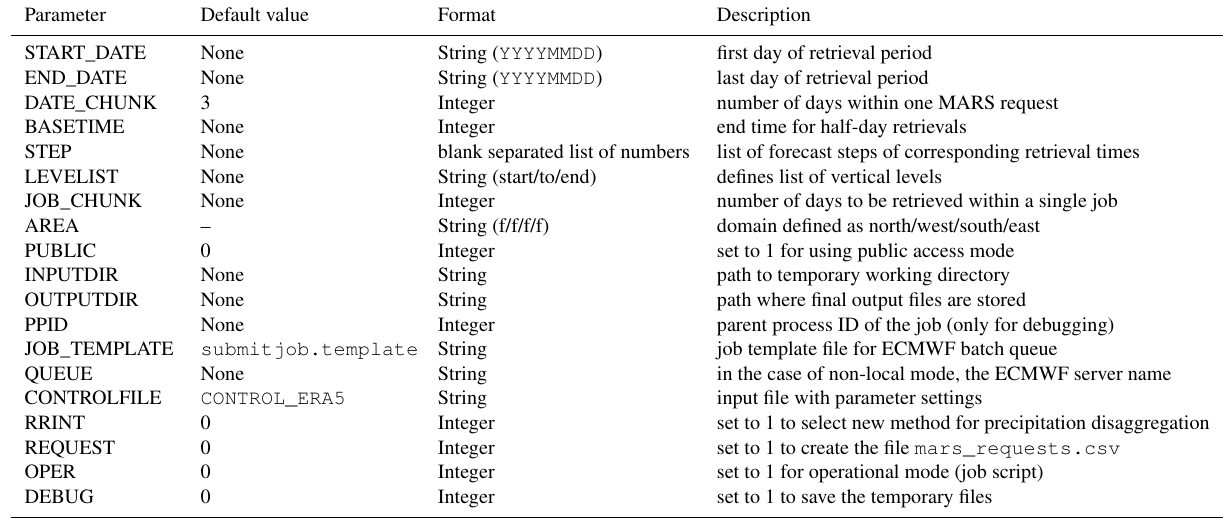
Table 12. Overview of the parameter to be set in the run*.sh script. In order to provide a complete list, some already defined parameters from Tables 8 and 11 are repeated here. In the case of a special format, a sample format is given in parentheses; f denotes a floating-point number.